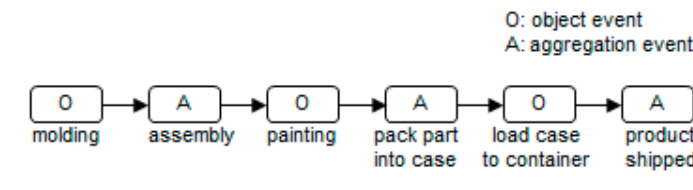
Figure 6. Target process for the benchmark test.